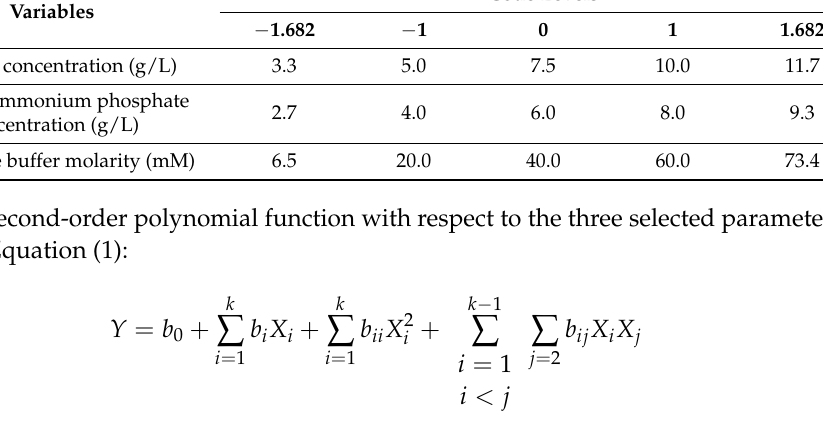
Table 4. Plackett–Burman experimental design. Run * Factor 1 2 3 4 5 6 Glucose − + + + + + Sodium ammonium phosphate + − +